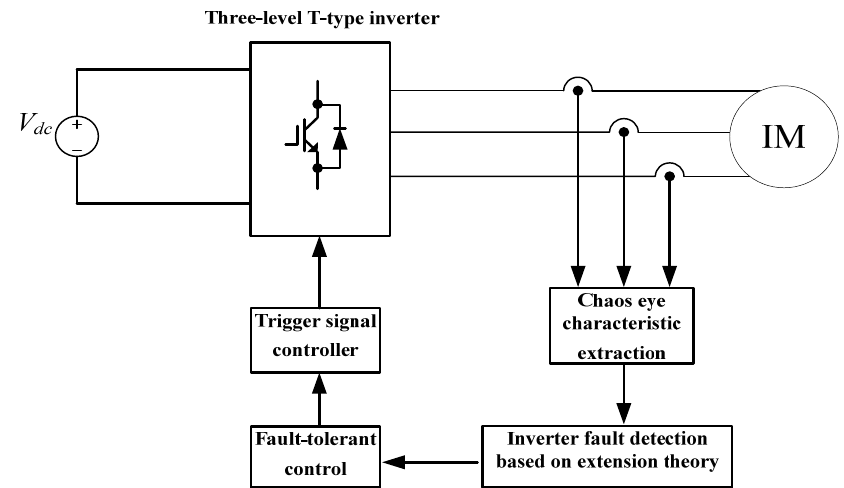
Figure 1. The architecture of fault-tolerant control system for a three-level T-type inverter.